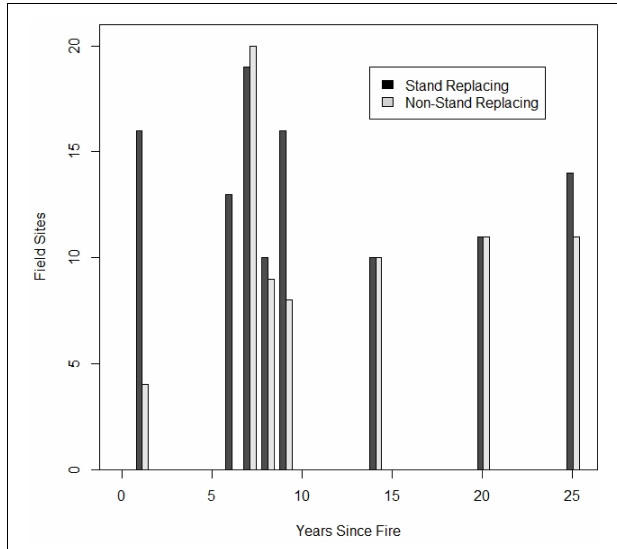
FIGURE 2 | Number of field plots sampled versus years since fire, separated by sites burned in stand replacing fire versus those burned in non-stand replacing fire. All shown plots only burned once in the last > 50